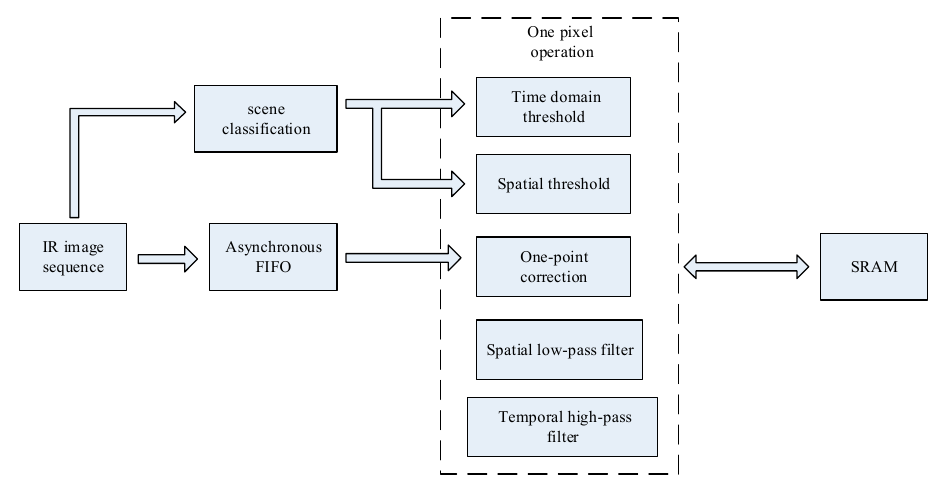
Figure 10. A conceptual schematic of hardware architecture.